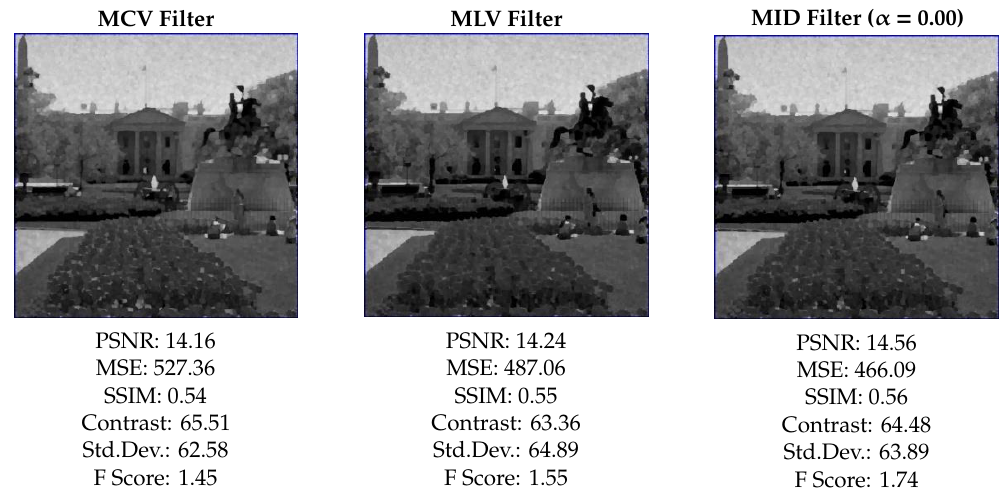
Table 2. Sample experimental results for a gray-scale picture taken from filters with 5 × 5 kernel size. MCV Filter